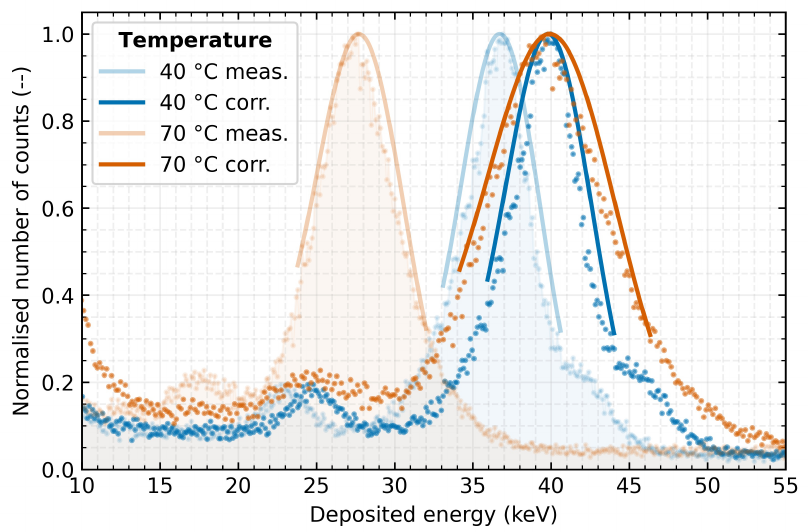
Figure 9. Measurement of the Europium radionuclide energy spectrum with the detector at 40°C and 70°C. Comparison of measured energy spectra before (light curves) and after linear correction (dark curves) according to dependencies in Figure